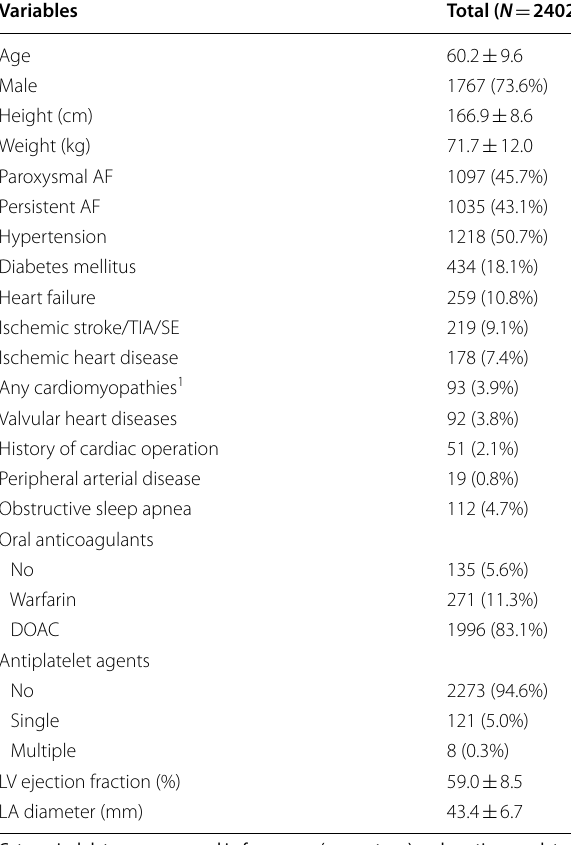
Table 1 Baseline demographic characteristics of the study population